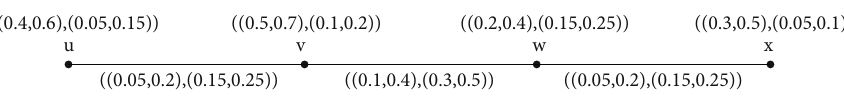
Figure 3: G is NETI-IVIFG but it is not NEI-IVIFG.